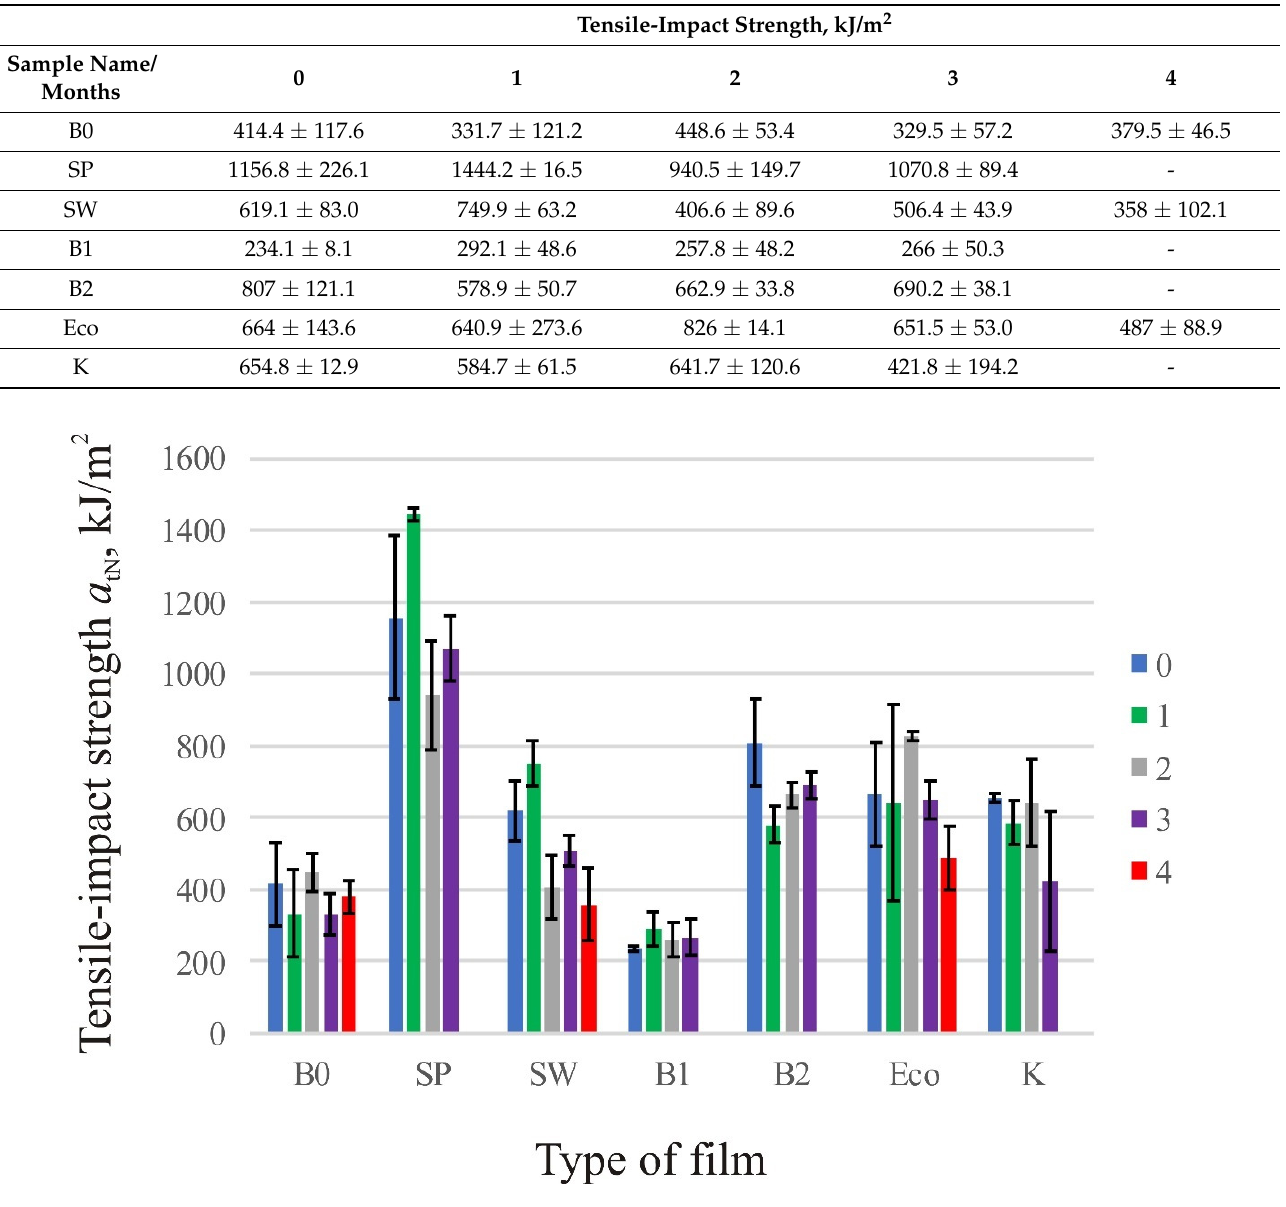
Table 6. Tensile-impact strength.